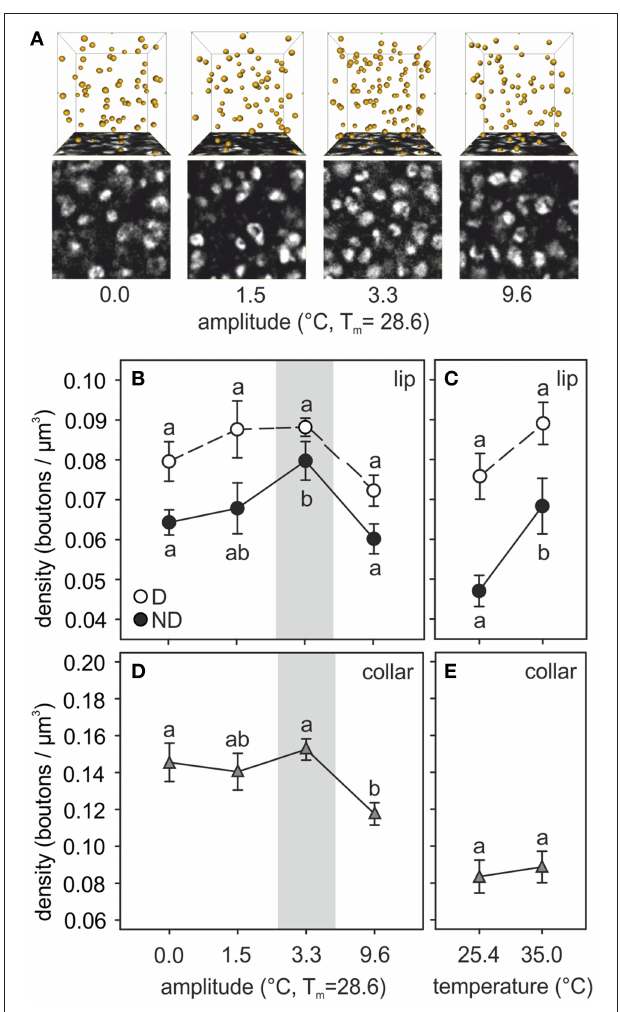
FIGURE 4 | Temperature effects on synaptic bouton densities. (A) Examples of synapsin-IR bouton quantification in the ND lip of ants reared at 0.0, 1.5, 3.3, and 9.6 ◦ C of thermal amplitude (mean temperature, T m : 28.6 ◦ C). Single confocal image of a 10 × 10 µ m 2 synapsin-stained area in the ND lip (bottom) and 3D reconstruction (top) of the position of the boutons visualized by AMIRA in a 1000 µ m 3 –volume ( 10 × 10 × 10 µ m 3 ). Each yellow sphere marks the center of a synapsin-IR bouton. (B–E) Presynaptic bouton densities in (B,C) the olfactory D and ND lip and (D,E) the visual collar input regions of the MB calyces of ants (B,D) reared at different amplitudes of fluctuating temperature but the same mean temperature or (C,E) different constant temperature regimes. Gray area shows the temperature regime selected by nurses for brood translocation. Symbols represent the mean value of each group and lines the S.E. Different letters indicate significant differences among amplitudes or between constant temperatures. Lip: N 0 = 13 , N 1.5 = 9 , N 3.3 = 10 , N 9.6 = 11 , N 25.4 = 11 , N 35 = 11 ; collar: N 0 = 10 , N 1.5 = 8 , N 3.3 = 11 , N 9.6 = 10 , N 25.4 = 11 , N 35 = 10 .